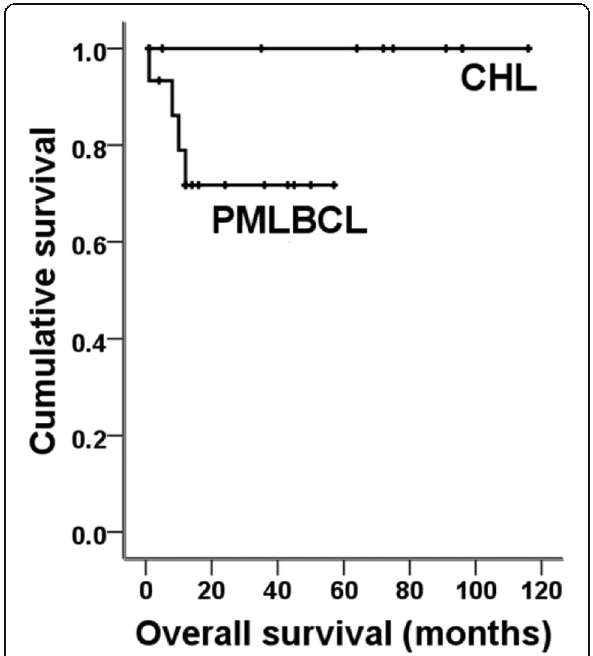
Fig. 1 Overall survival of patients with primary mediastinal large B- cell lymphoma and classic Hodgkin